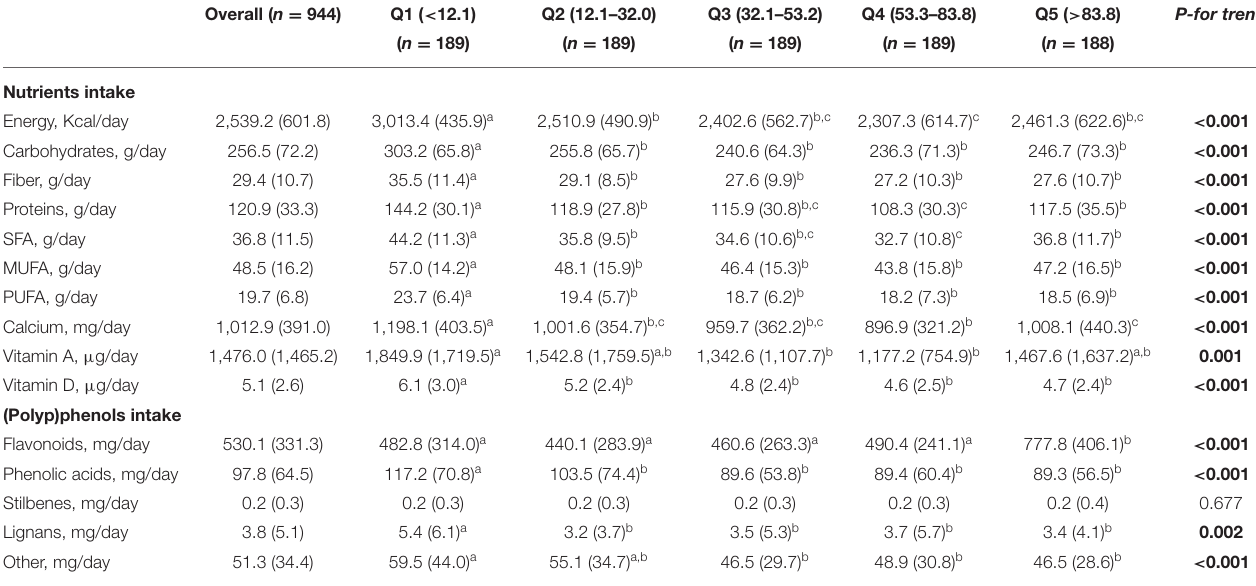
TABLE 3 | Nutrients and (poly)phenols intake of participants according to quintiles of flavonoids from cocoa-based products (mg/day).